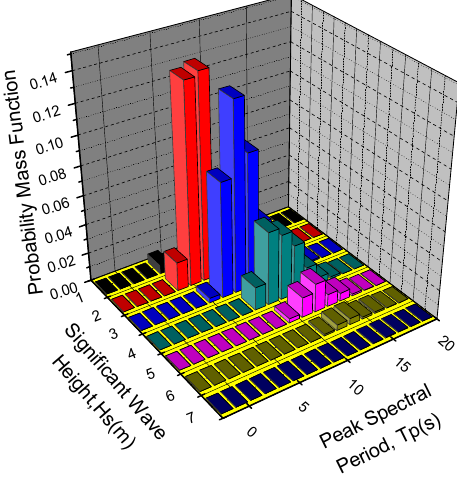
vs. T ( V = 11.4 S P hub